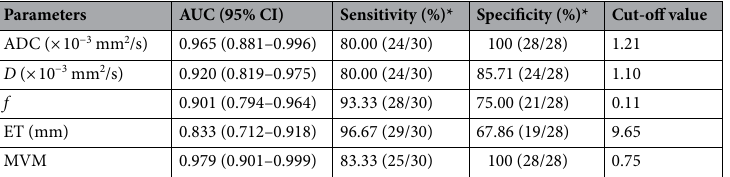
Table 3. Performance of ADC, D , f , ET and the multivariable model of ADC, D and f values in diagnosing endometrial fibrosis. ADC apparent diffusion coefficient, D true diffusion coefficient, f perfusion fraction, ET endometrial thickness, MVM a multivariable model combing ADC, D and f values using the binary logistic regression analysis, AUC area under ROC curve, CI confidence interval. *Data in parenthesis are numerator/ denominator.